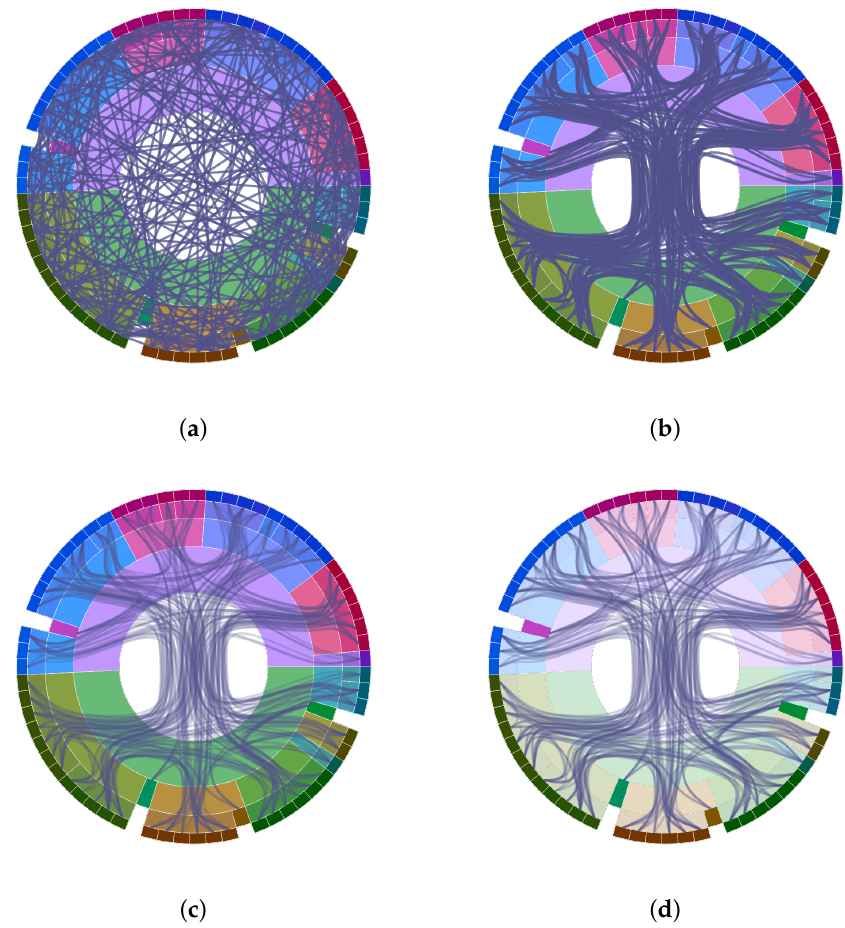
Figure 7. Adjustment of edge bundling tension ( β ) and transparency ( α n and α c for nodes and connections, respectively). ( a ) α c = 0.75, α n = 0.75, β = 0.0. Low transparency and no edge bundling. ( b ) α c = 0.75, α n = 0.75, β = 0.8. Increasing edge bundling tension. ( c ) α c = 0.25, α n = 0.75, β = 0.8. Increasing transparency in the connections. ( d ) α c = 0.25, α n = 0.25, β = 0.8. Increasing transparency in the internal nodes of the